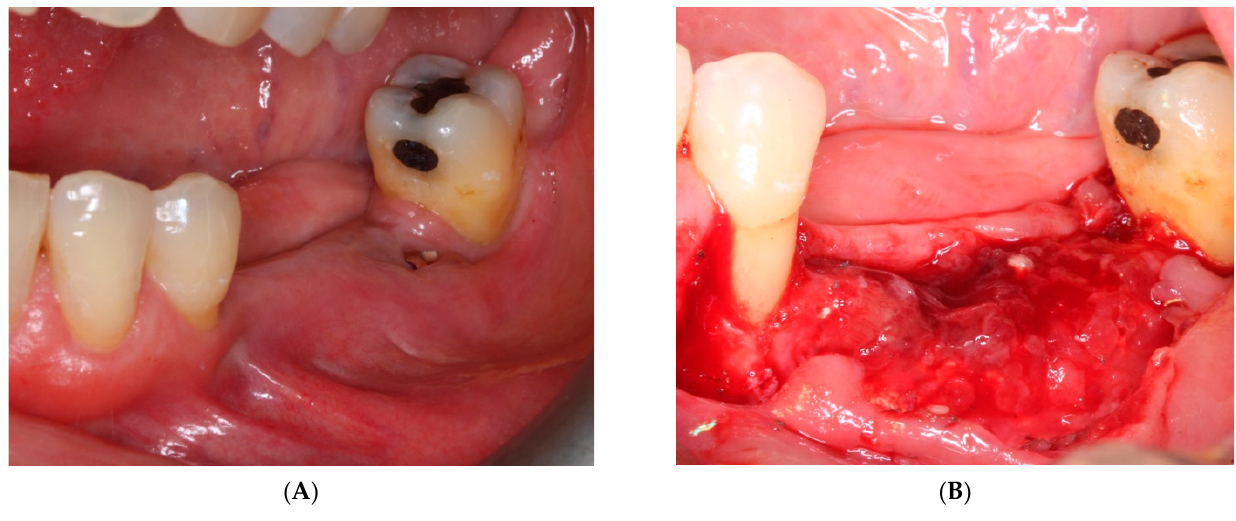
Figure 9. ( A ) Control at 6 months and discreet exposure of the titanium mesh. ( B ) Mesh removal. Immature bone is observed, clear gain is seen in the two areas near the bone peaks and less loss in the central area of the defect.